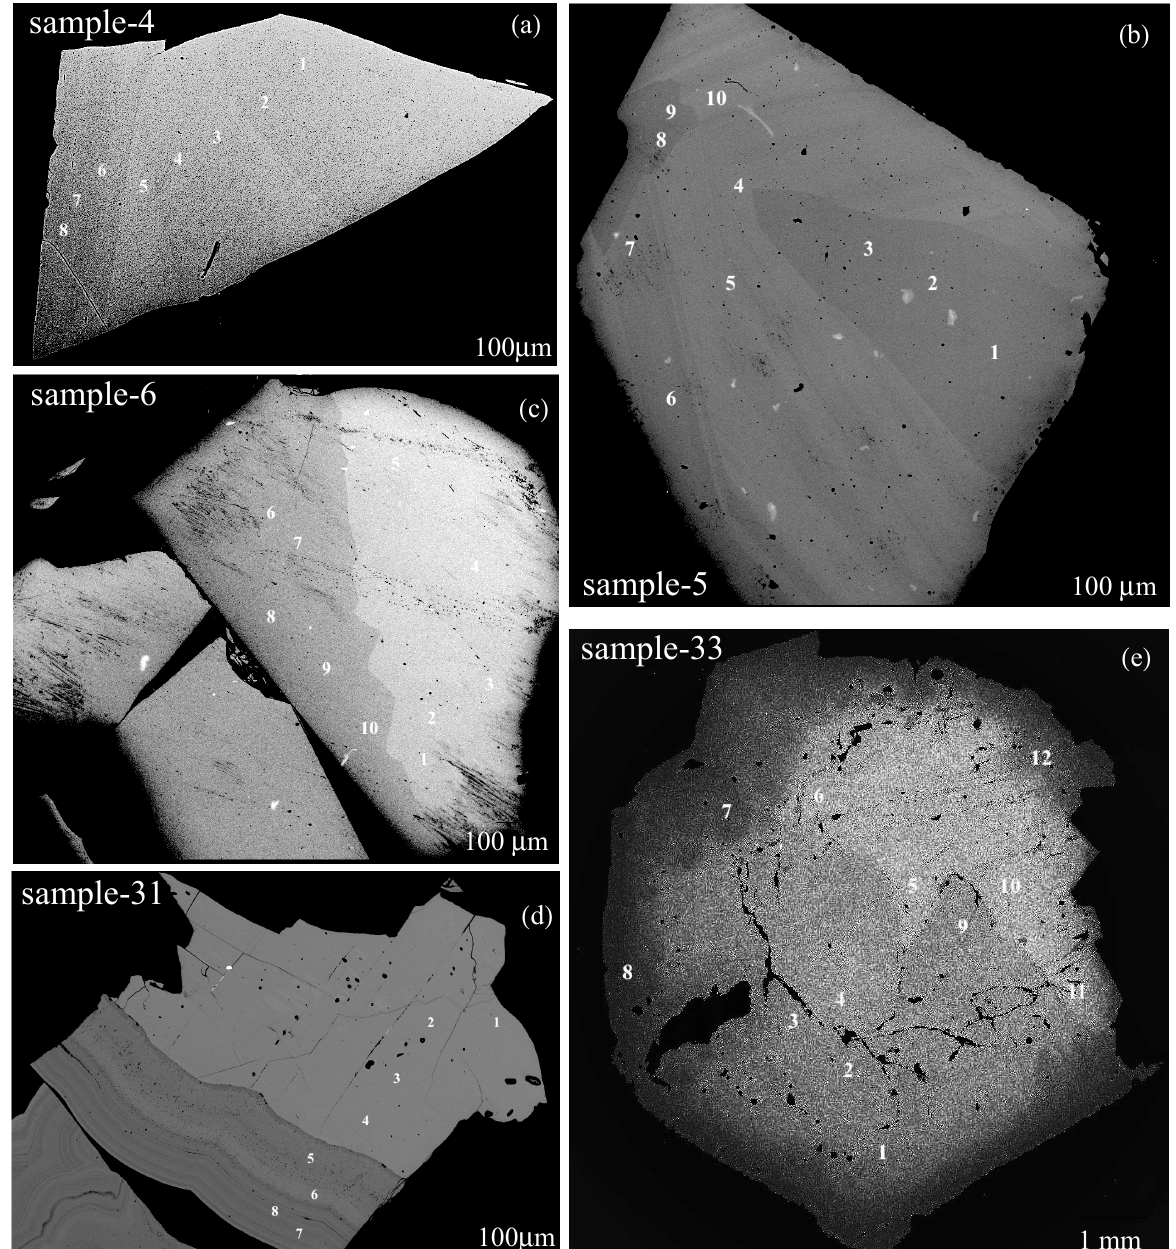
Figure 3. Back-scattered electron (BSE) images for five different Ap samples that contain different features of zoning. OH and F differ by only one electron, so the observed zoning is not based on these anions, but based on cations replacing Ca cations: ( a , b ) A two-phase intergrowth of F-Ap and OH-Ap occurs in samples-4 and -5 where the contrast differences arise from variations in Ca and Mn cations (see Figure 4a,b); ( c , d ) Zoning in a single-phase sample-6 and a two-phase sample-31 where the contrast differences arise from variations in Mn + Sr replacing Ca cations (see Figure 4c,d); ( e ) A three-phase intergrowth of three slightly different F-Ap phases in sample-33 where the contrast differences arise from variations in Ca and Mn cations (see Figure 4d). The multiple phases are recognized by splitting of reflections in the HRPXRD traces, as discussed below.